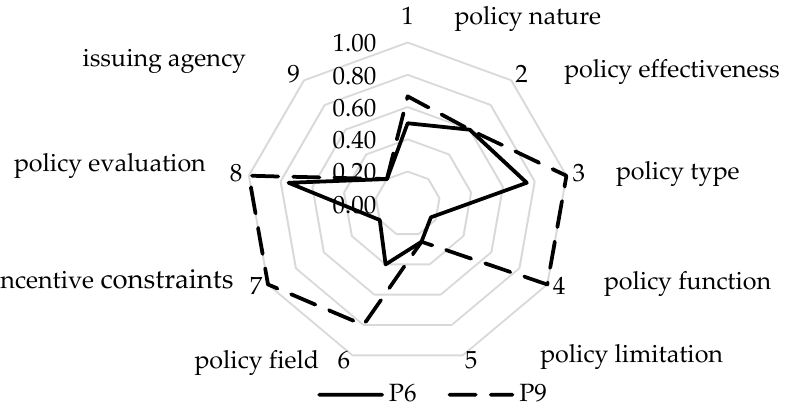
Figure 4. Comparison of multi-dimensional evaluation of policies P6 and P9.